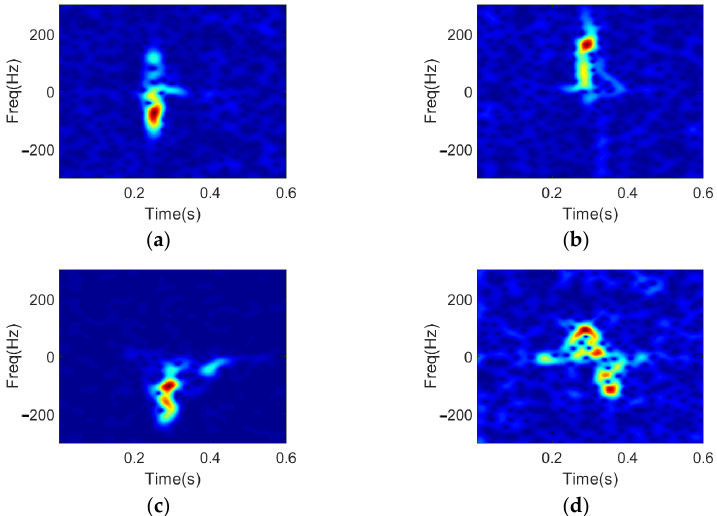
Figure 7. Spectrograms of received signals corresponding to four dynamic hand gestures: ( a ) snap- ping fingers, ( b ) flipping fingers, ( c ) clenching hand, ( d ) clicking fingers.